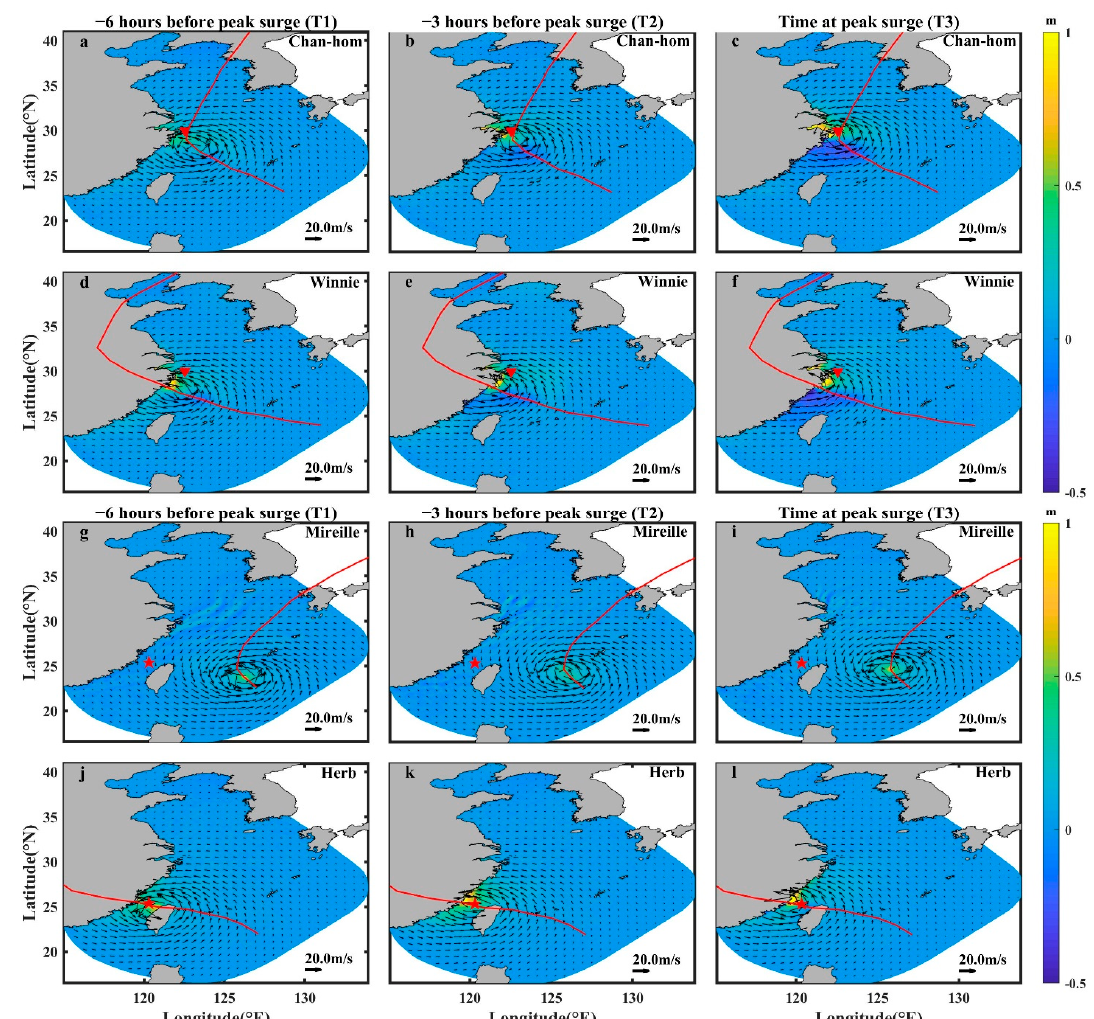
Figure 12. Model simulated wind field at time T1, T2, and T3 (at LH station) for the typhoon paths of Chan-hom ( a – c ) and Winnie ( d – f ); model simulated wind field at time T1, T2 and T3 (at PT station) for the typhoon paths of Mireille ( g – i ) and Herb ( j – l ). The red line represents the typhoon path.